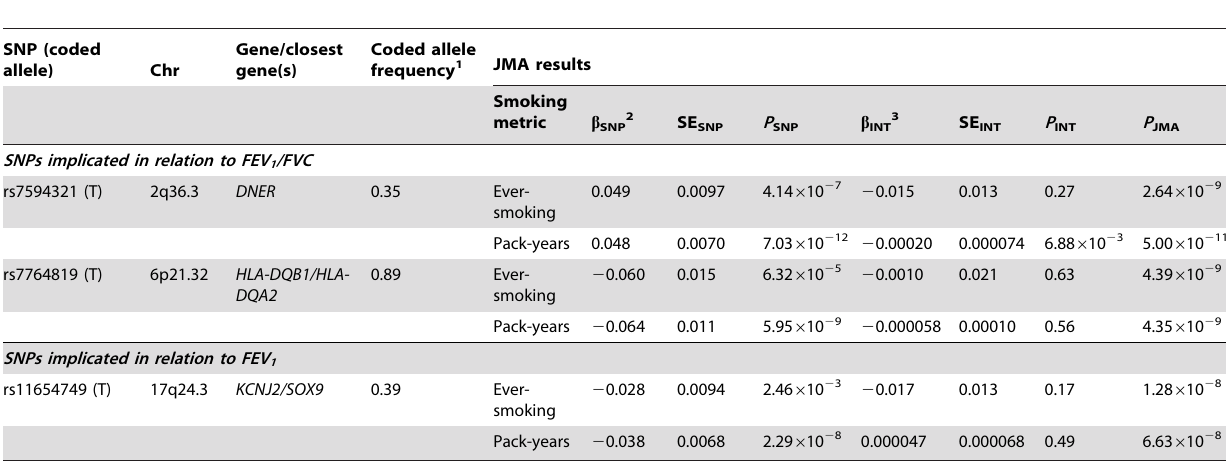
Table 1. Genome-wide significant SNPs from the joint meta-analysis (JMA) of SNP and SNP-by-smoking (ever-smoking or pack- years) interaction in relation to pulmonary